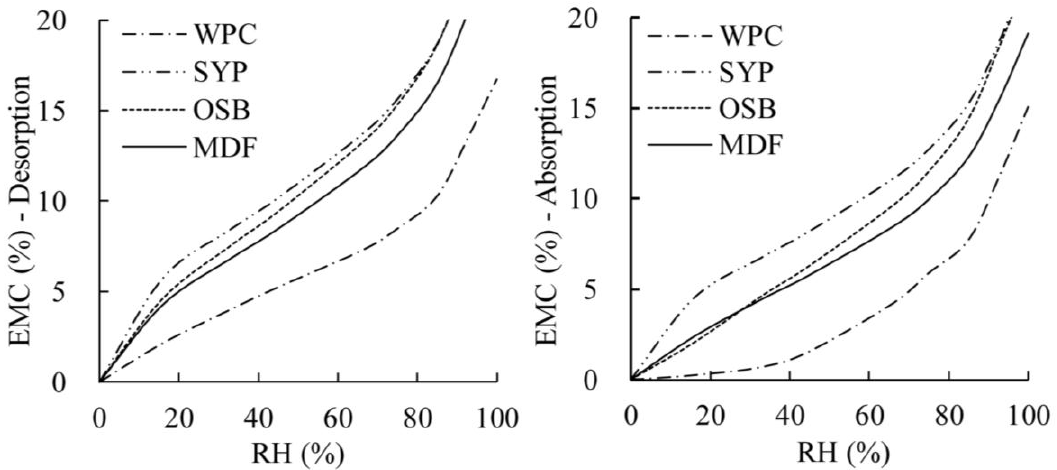
Figure 6. Comparison of sorption isotherm predicated by Nelson’s model for different types of